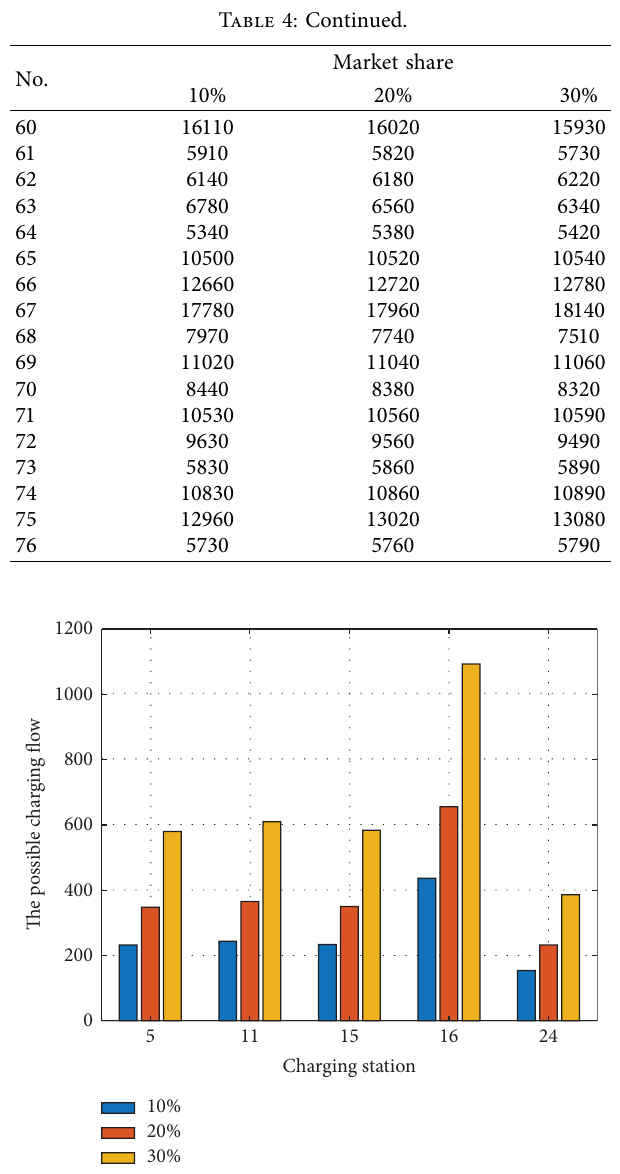
Figure 7: Comparison of possible charging diferent BEV market